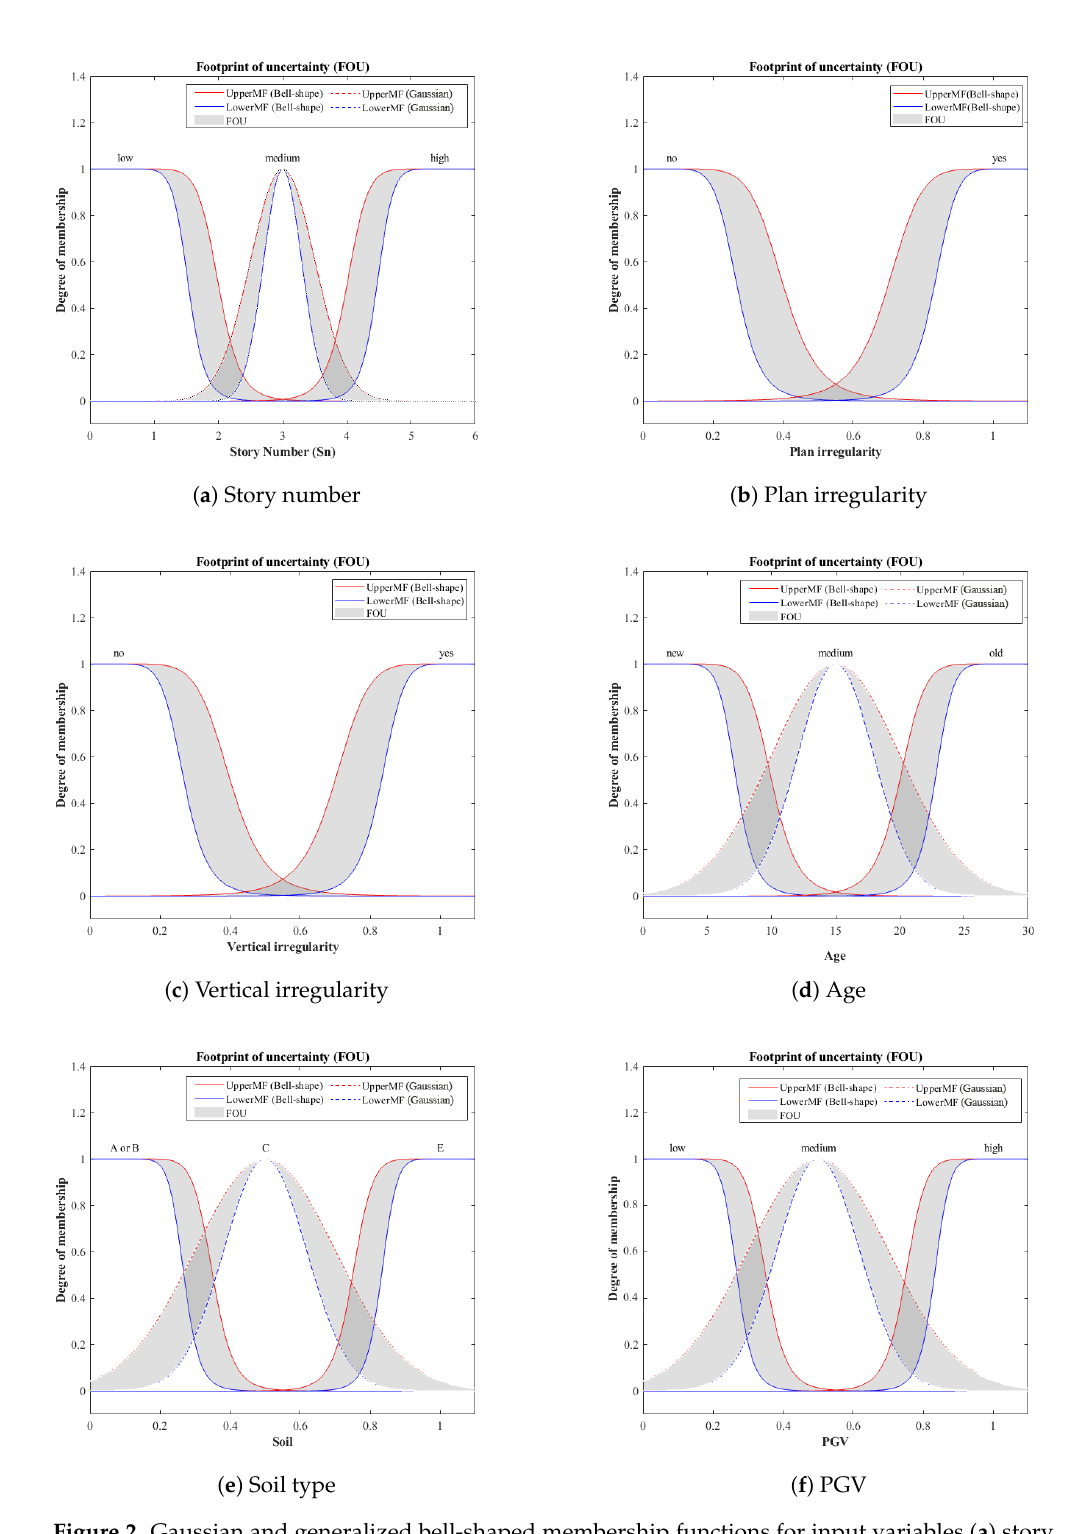
Figure 2. Gaussian and generalized bell-shaped membership functions for input variables ( a ) story number, ( b ) plan irregularity, ( c ) vertical irregularity, ( d ) age, ( e ) soil type, ( f )